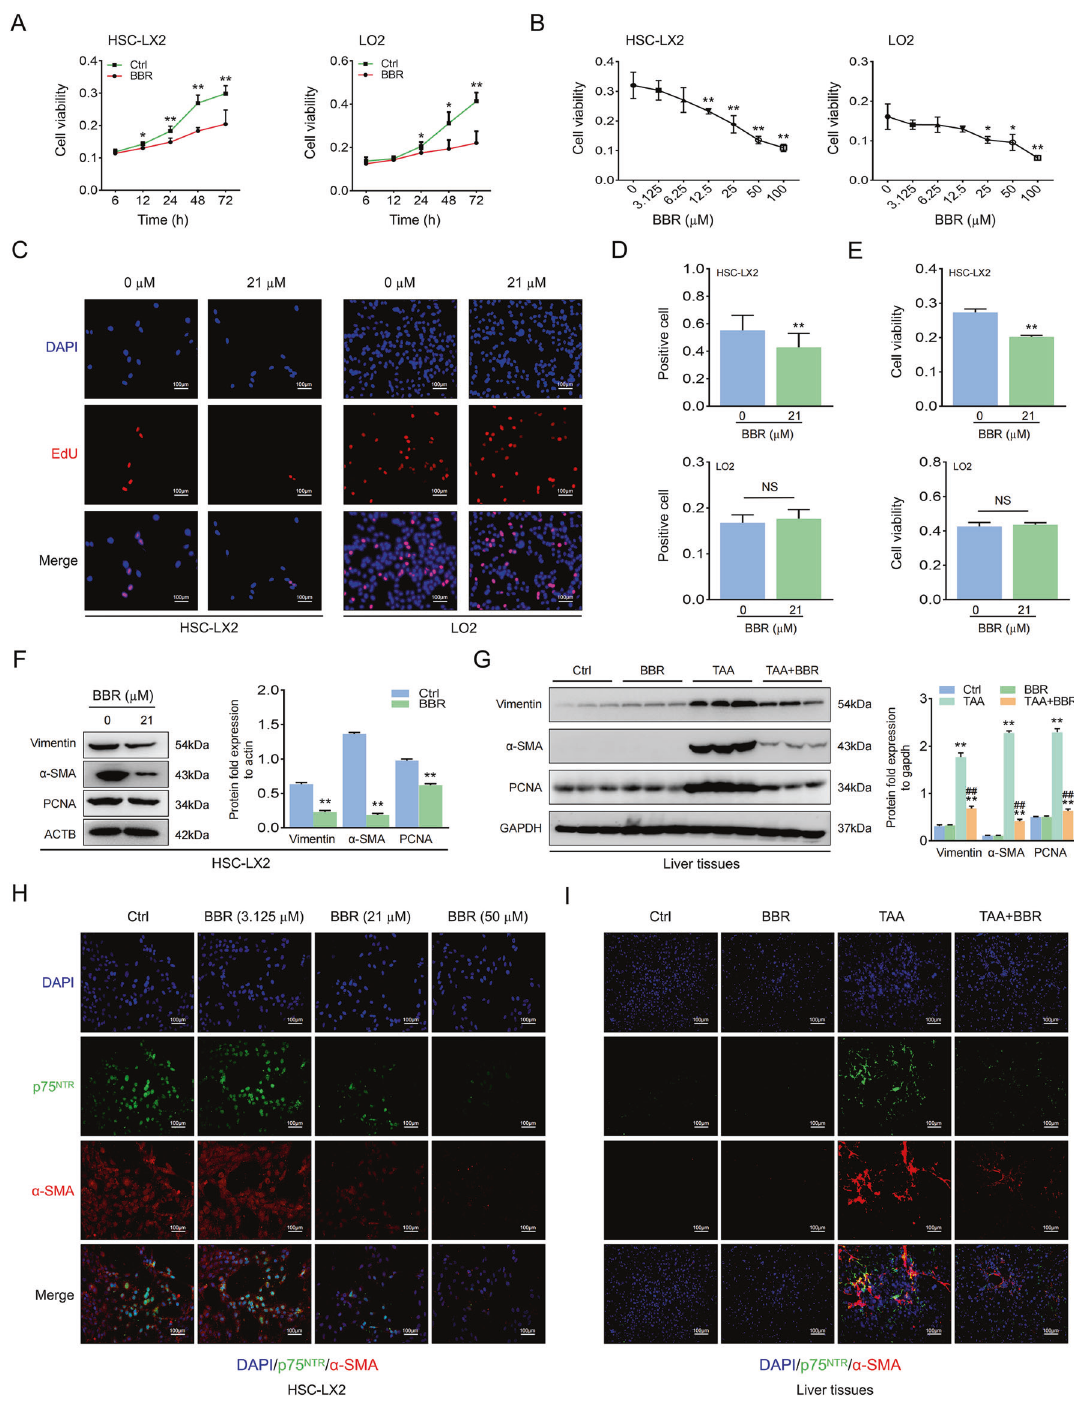
Fig. 2 BBR inhibits HSC activation in vivo and in vitro. A , B HSC-LX2 and human hepatocyte LO2 cells were treated with BBR (50 μ M) for the indicated time or cells were treated with different concentrations of BBR for 48 h, and cell viability was determined by CCK-8 assay. C – E Administration of HSC-LX2 and hepatocyte LO2 with BBR (21 μ M) for 24 h; cell proliferation and viability were investigated by EdU and CCK-8 assays. F HSC-LX2 were treated with BBR (21 μ M) for 24 h, then a whole-cell lysate was taken for western blot to investigate the Vimentin, α -SMA, and PCNA proteins. G Protein expression of Vimentin, α -SMA, and PCNA in TAA-induced mouse liver fi brosis. H , I Costaining of p75 NTR and α -SMA in HSC-LX2 or TAA-induced mouse hepatic fi brosis. The results are expressed as mean ± SD. Data are representative of three independent experiments; n = 3 – 6 in every group; Scales: 100 μ m. Representative photographs are shown. Compared with the control group, * P < 0.05, ** P < 0.01; compared with the model group, ## P < 0.01. NS, not signi fi cant.